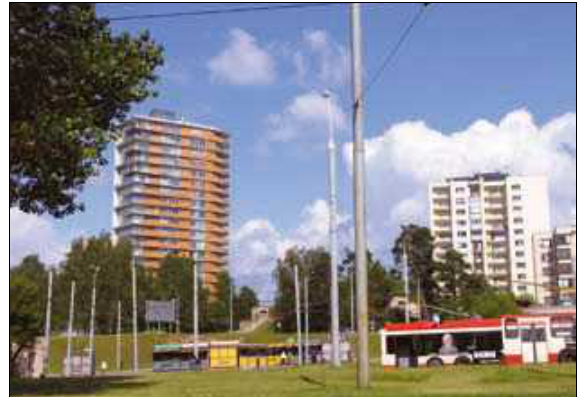
Fig. 11. high-rise block of flats in Žirgas st. Ua­b „a­rchitektūros kūrybinė gru­pė“